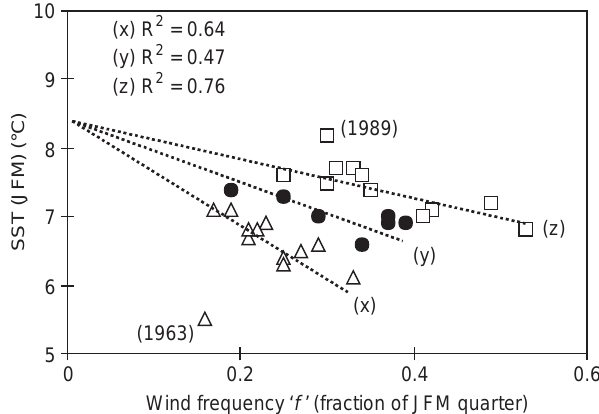
Fig. 1. Relationships between SST and W-NW-N (240 (cid:176) -30 (cid:176) ) wind frequency ( f ) during the first quarter (JFM) of each calendar year between 1961 and 1991. Data for the exceptionally cold winter of 1963, when anticyclonic blocking conditions prevailed over the NA (Barry and Chorley, 1992), and for the exceptionally warm winter 1989, when an anomalous poleward displacement of the Gulf stream took place (Ginkul and Gavrilyuk, 1991), were not included in the regression analyses. The regression relationships were forced through a common intercept (8.4 (cid:176) C) in keeping with their divergent tendency